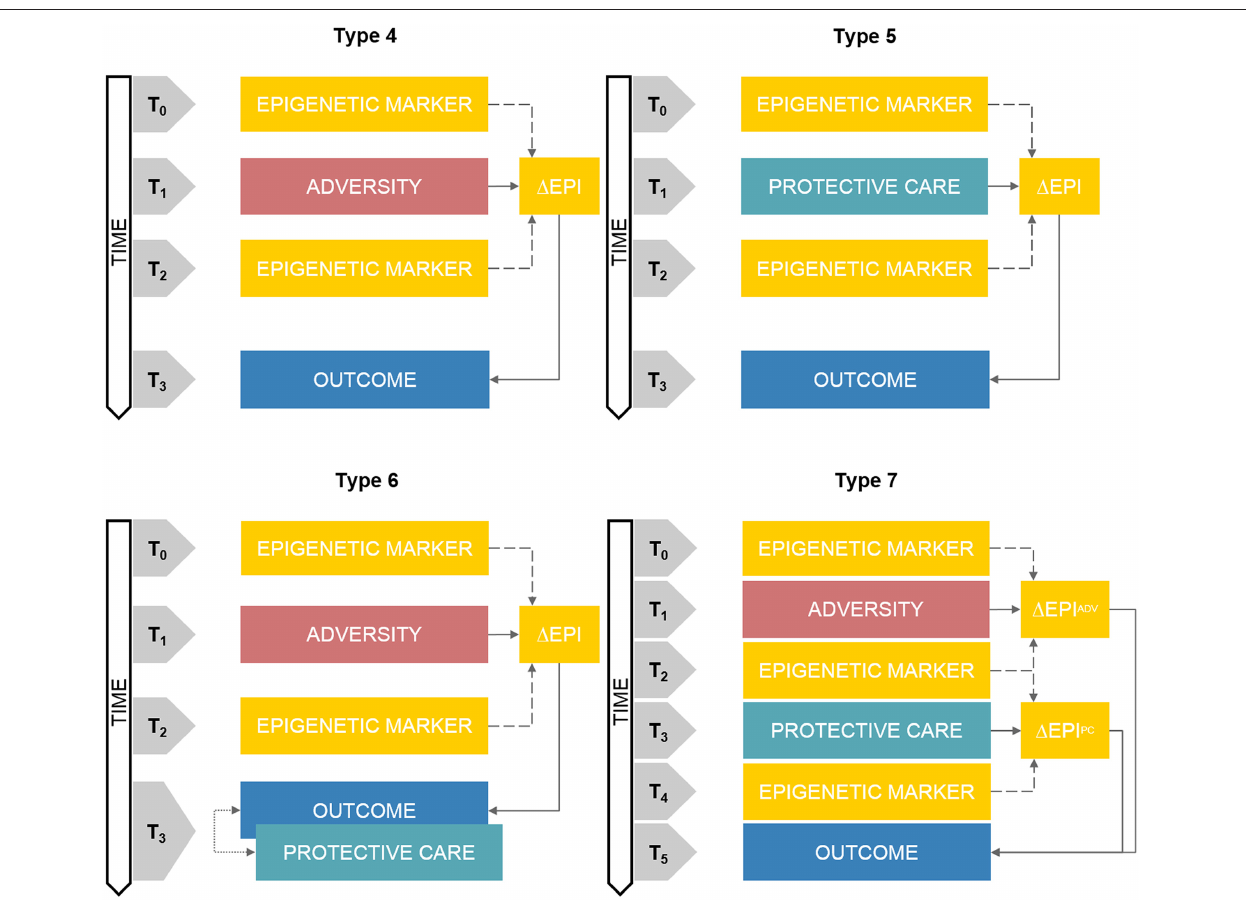
FIGURE 2 | Schematic representations of prospective DHBE study designs. Note. Type 4: prospective assessment of adversity-related epigenetic variations on longitudinal outcomes. Type 5: clinical trials of care-related epigenetic variations on longitudinal outcomes. Type 6: prospective assessment of adversity-related epigenetic variations on longitudinal outcomes with concurrent exposure to protective care. Type 7: prospective and sequential assessment of adversity- and care-related epigenetic variations on longitudinal outcomes. (cid:49) EPI box, Epigenetic variation; (cid:49) E ADV box, Adversity-related epigenetic variation; (cid:49) E PC box, Protective care-related epigenetic variation. Double-headed arrows reflect correlational associations. The annotation t n refers to progressive time-points in the research study